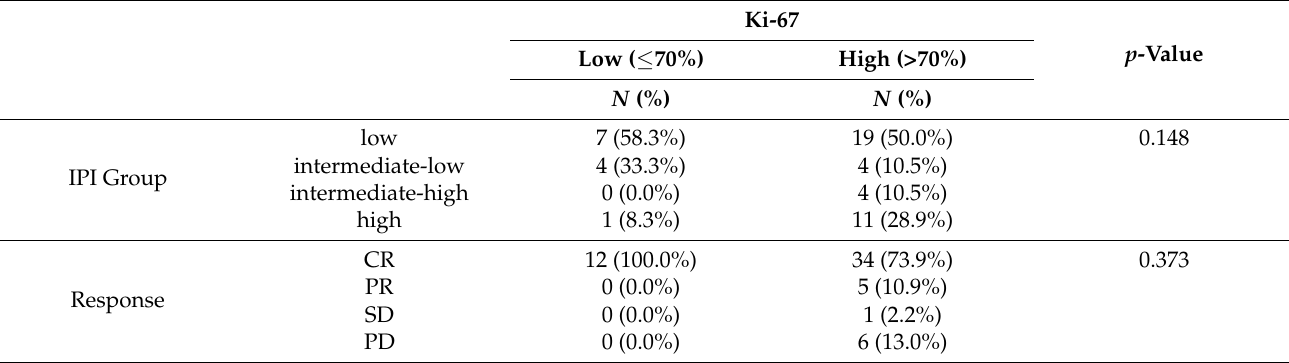
Table 2. Analysis of differences in international prognostic index (IPI) and treatment response between low and high Ki-67